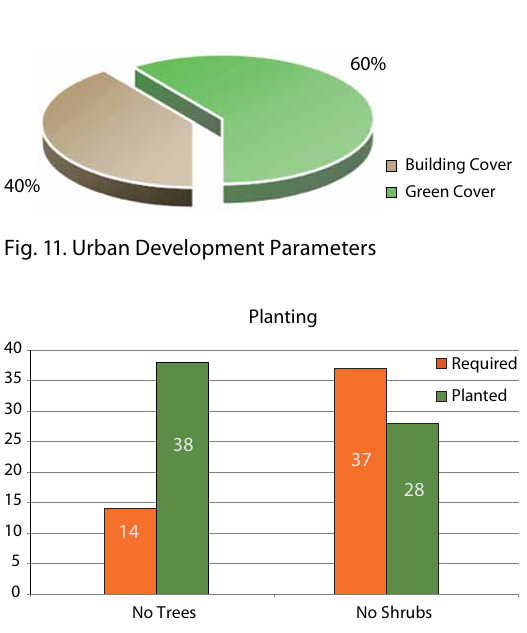
fig. 12. Planting requirement and Implementation